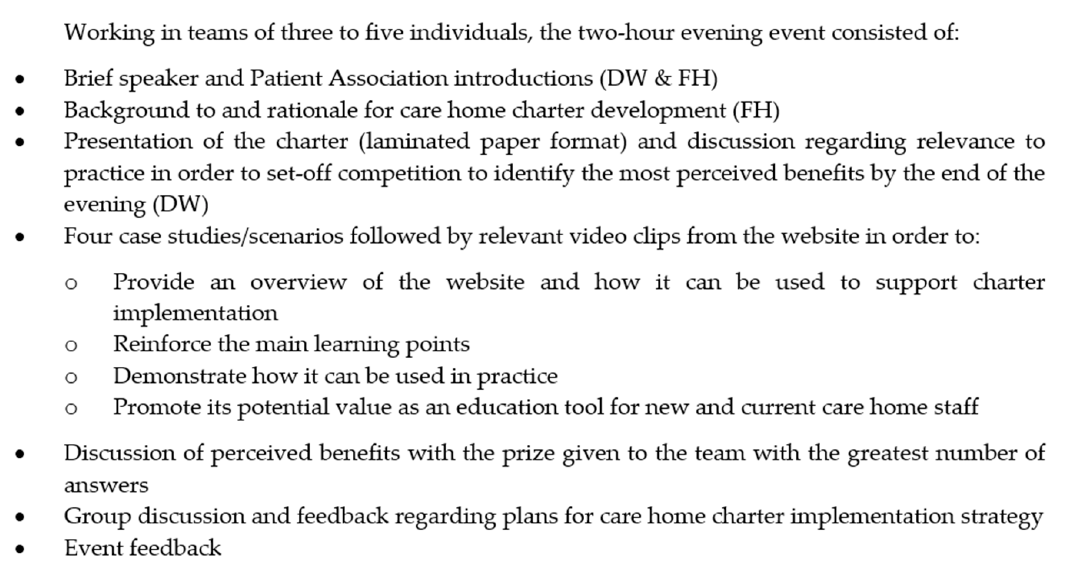
Figure 2. Care home charter launch and training event plan.